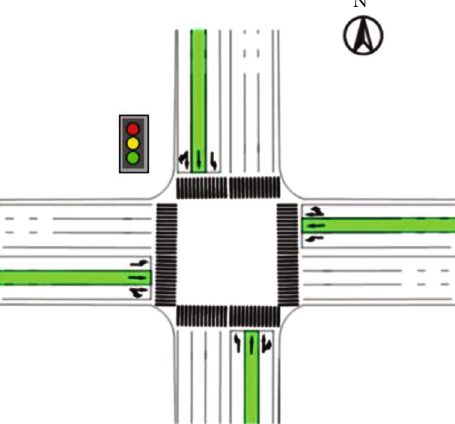
Figure 4: The distribution of each lane of the entrance lane of the